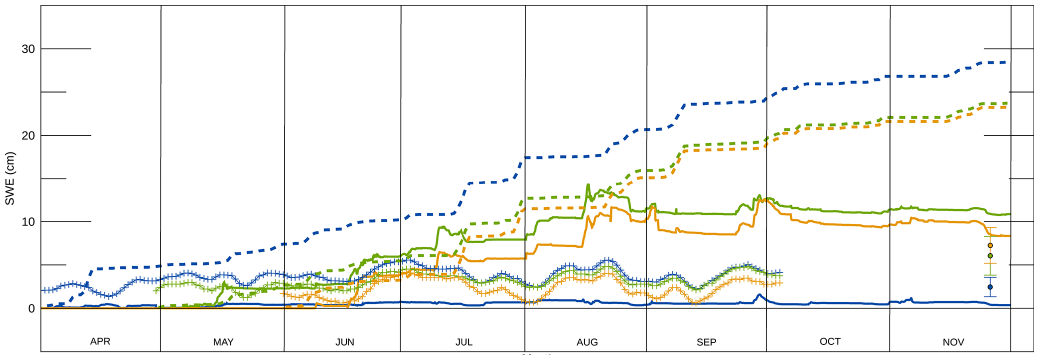
Figure 2. SnowModel hourly (solid lines) and ERA-I daily (hashed lines) snow water equivalent (s.w.e.) accumulation and AMSR-E daily snow depth (crosses) converted to s.w.e. for fastening areas 1 (blue), 2 (green) and 3 (orange). The mean in situ s.w.e. and standard deviations for each area are displayed as circles at the end of November and colour coded to their respective fastening areas.